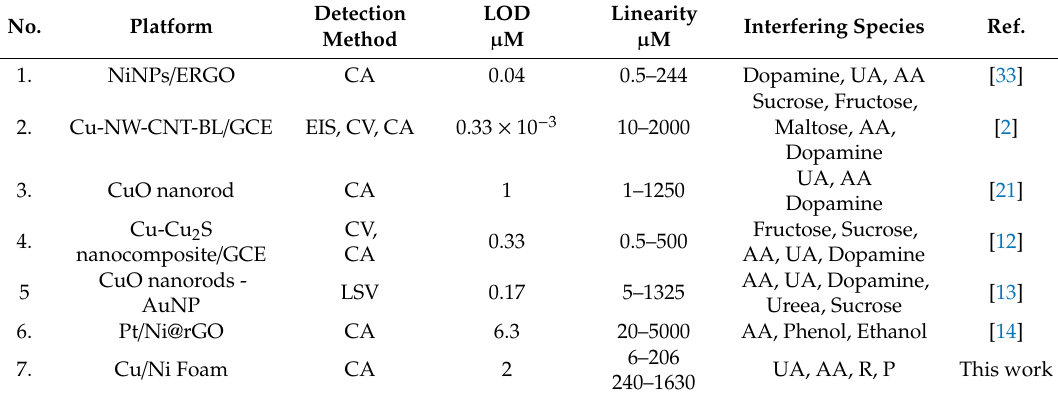
Table 4. Cu- and Ni-based electrochemical enzymeless sensors developed for Glu detection and their analytical